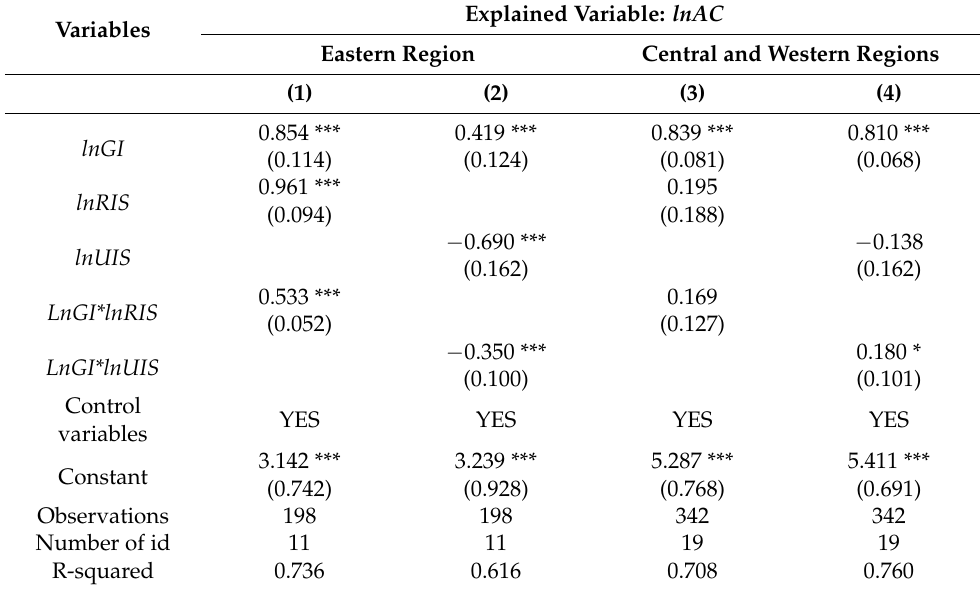
Table 8. Regression results of regional